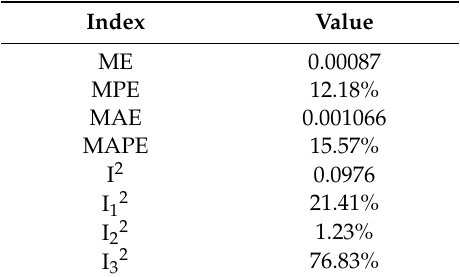
Figure 13. Results of ex–post axial total and plastic strain calculations as a function of a number of cycles. Table 4. Ex-post analysis results for the Simple Hysteresis Loop Model (SHLM) error calculations and Theil parameter Table 3. Ex – post analysis of the 10,000th cycle: error and percentage error calculation results. ε aT,10000 test ( – ) ε aT,10000 prognosis ( – ) sample no. Error ( – ) Procentage error (%)